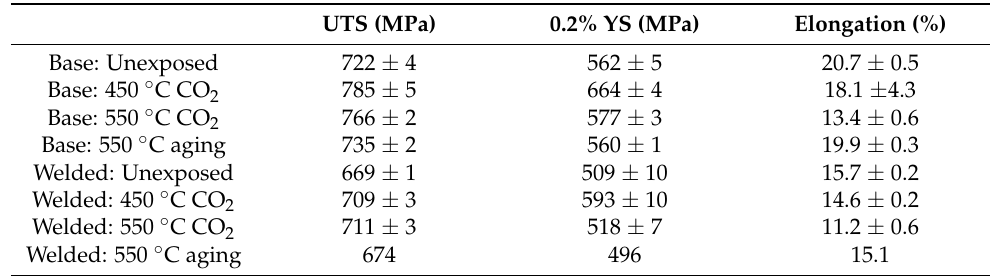
Table 1. Results of tensile properties for FMs Grade 92 after the given exposure. Data were obtained from reference [20]. Reproduced with permission from Springer